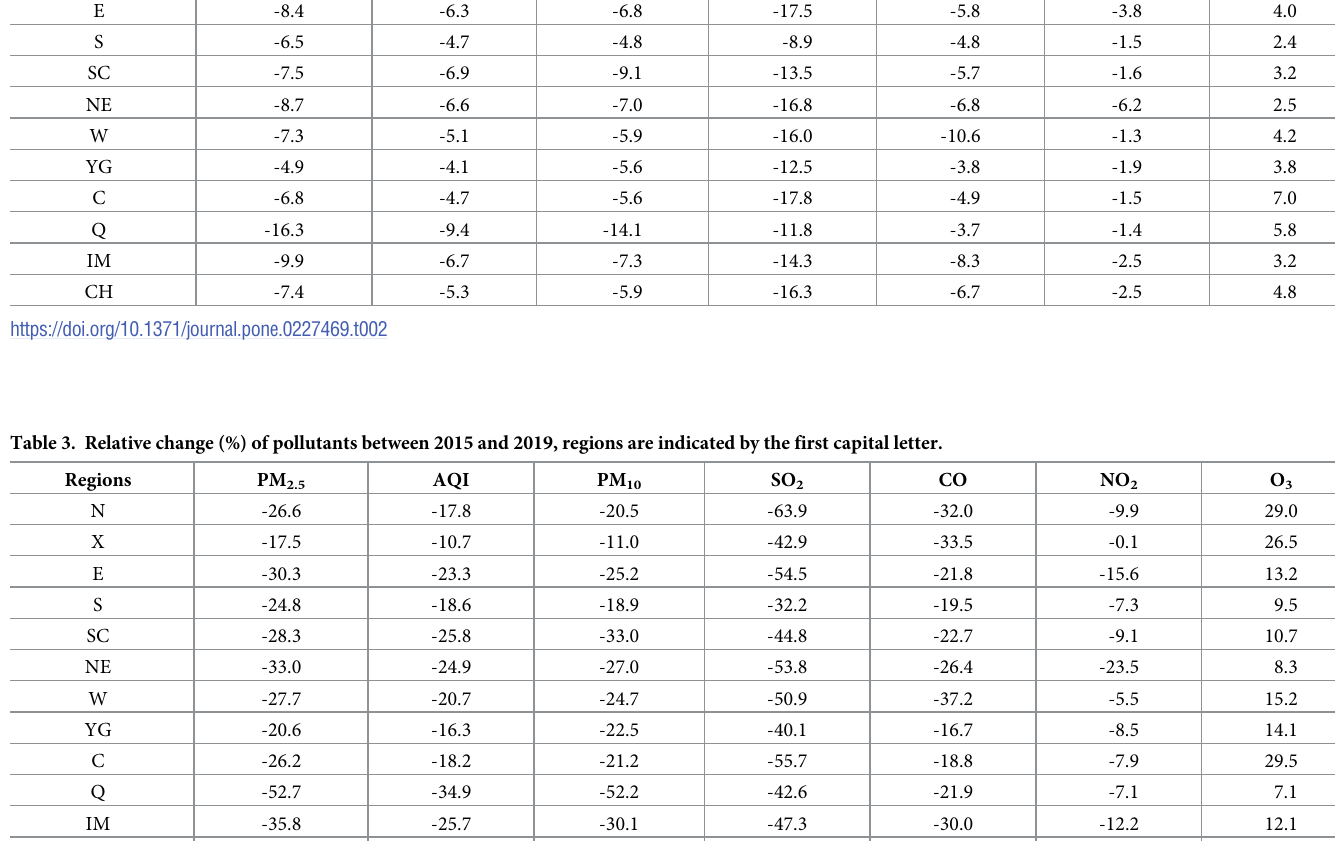
Table 2. Annual average relative change (%) of pollutants from 2015 to 2019, regions are indicated by the first capital letter. Regions N